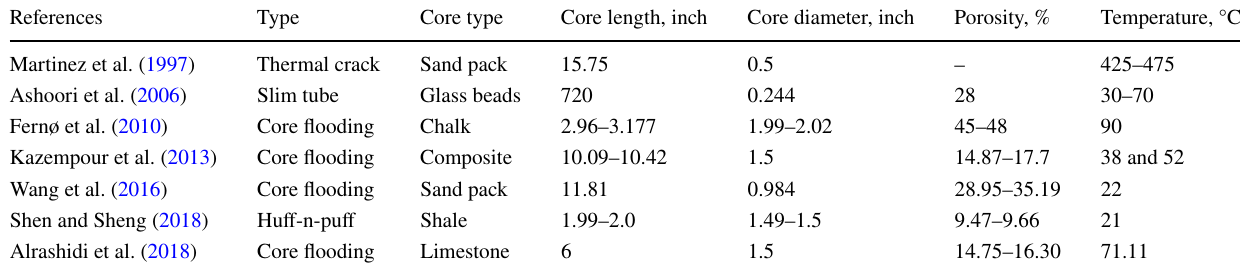
Table 6 Core properties for asphaltene pore plugging